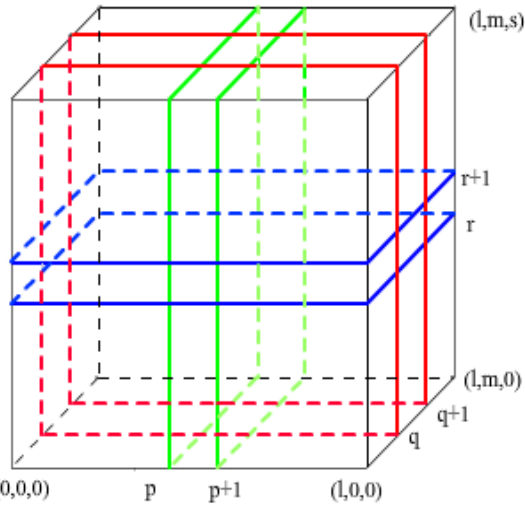
Figure 2. The solution domain is divided into eight